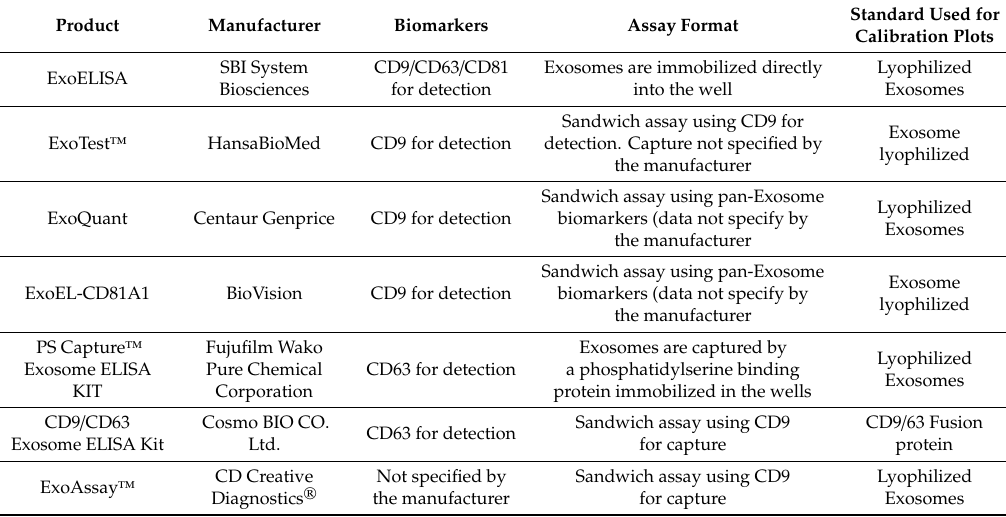
Table 1. Some commercial available kits based on enzyme-linked immunosorbent assay (ELISA) for exosomes quantification in biological samples. Most of them 1 are based on colorimetric signal quantification based on horseradish peroxidase (HRP) substrates, with a typical format of 96-well microtiter